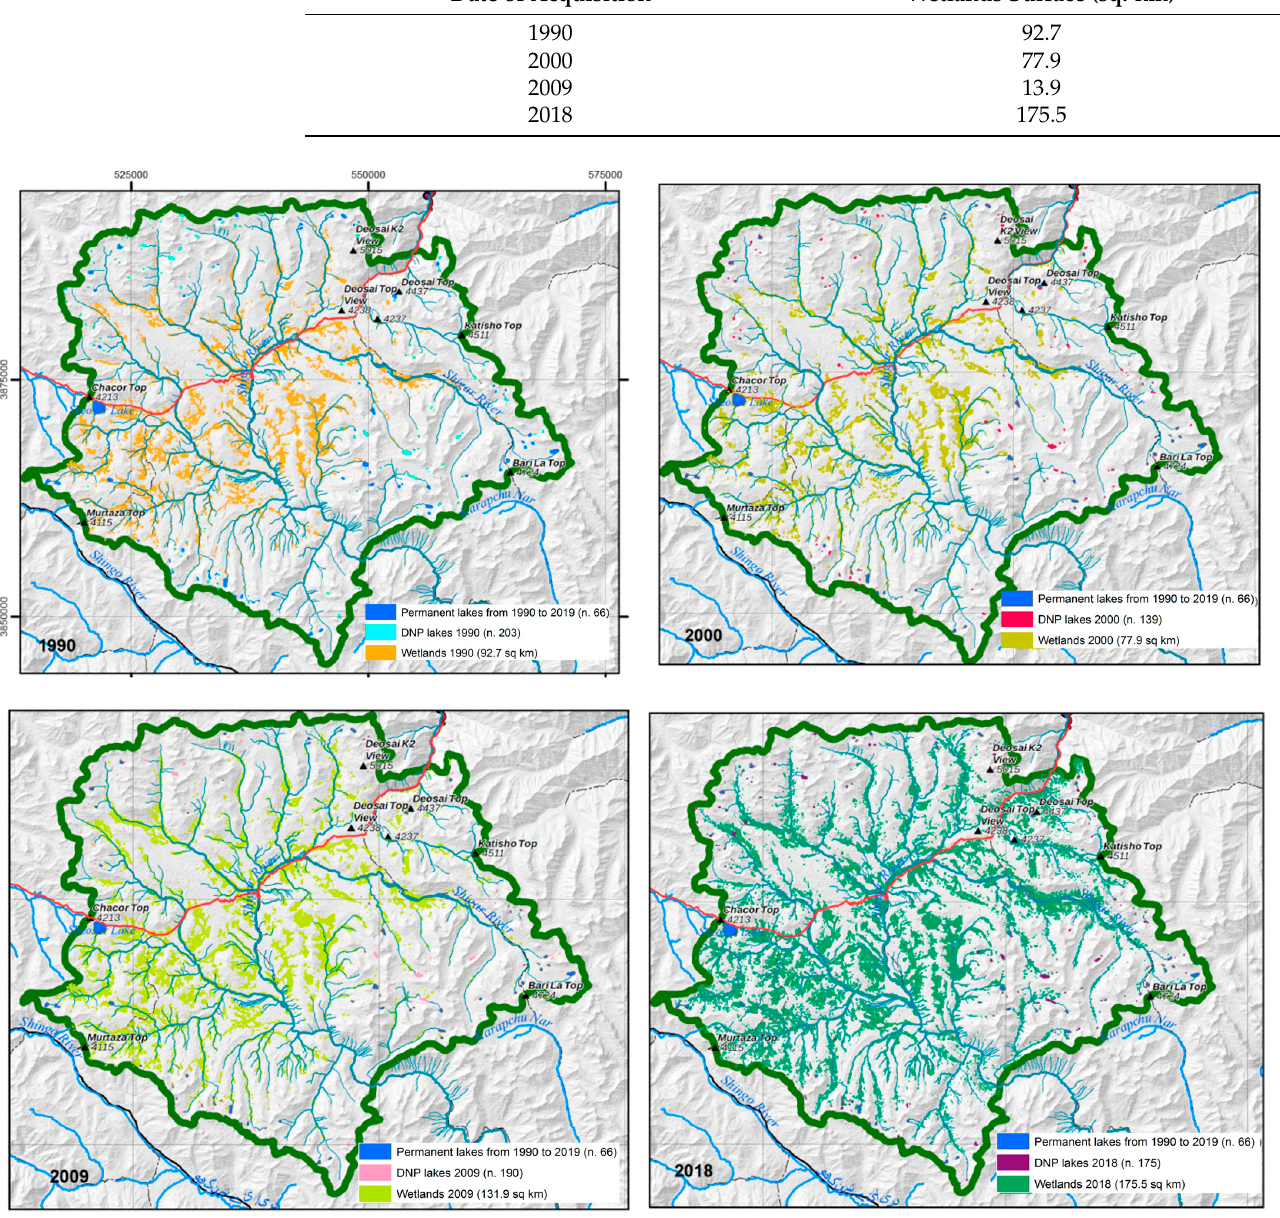
Figure 7. Diachronic maps of the distribution of lakes and wetlands in DNP. The coordinates are expressed in meters, as in Figure 2.